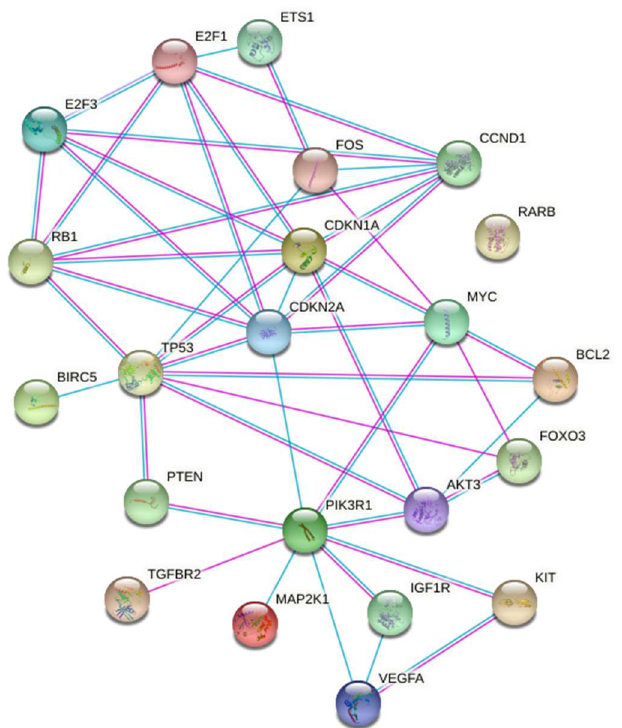
Figure 4. STRING representation of the molecular and biochemical relationships among the genes selected after the enrichment analysis.